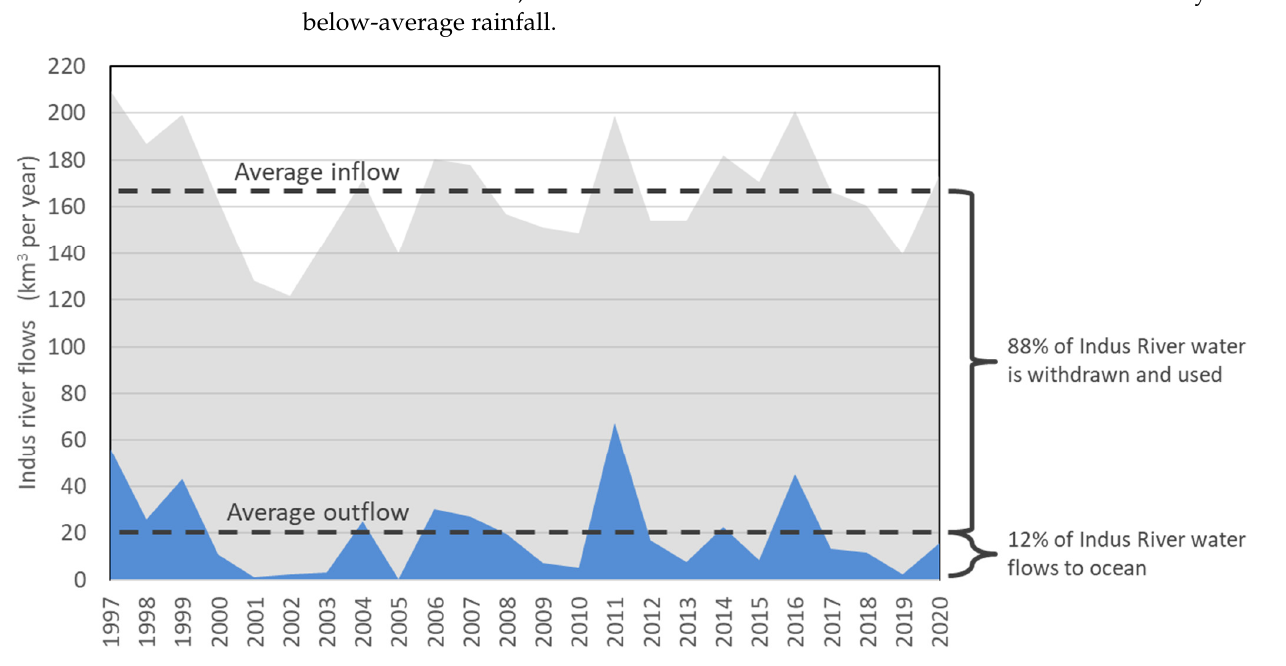
Figure 6. The Krishna River basin is reaching closure, limiting its ultimate supply to urban water users.